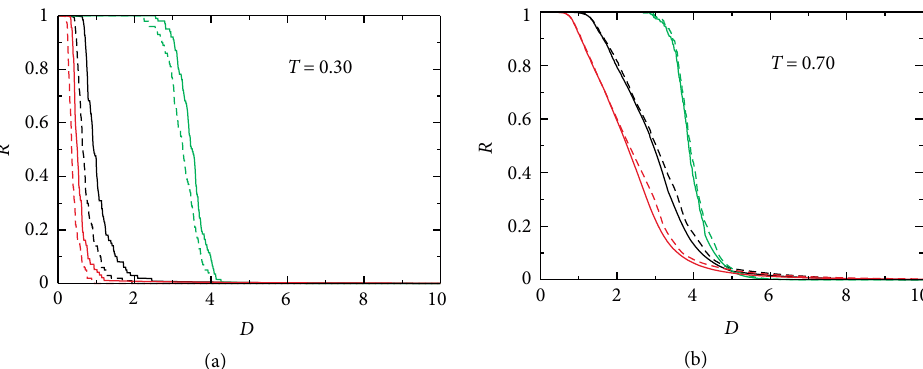
Figure 9: Market robustness 𝑅 as the function of transmitting shock level 𝐷 in external and internal link coupling scenario with ER random network (solid lines) and scale-free network (dashed lines) for internal links. Both layers have ⟨𝑘 in ⟩ = 4 and 𝑇 = 0.30 (a) and 𝑇 = 0.70 (b). We simulate different weight distributions: uniform 𝐶 ∼ 𝑈[0, 10] (black), exponential 𝐶 ∼ 𝐸𝑥𝑝[5] (red), and truncated normal 𝐶 ∼ 𝑁(𝐶 = 5, 𝜎 = 1) in the range [0, 10] (green). For the SF network, the minimum connectivity is 𝑘 min = 2 , the maximum connectivity 𝑘 max is the size of each layer and 𝜆 = 2.65 . The initial shock is on the venture capital market. The results were averaged over 100 realizations.